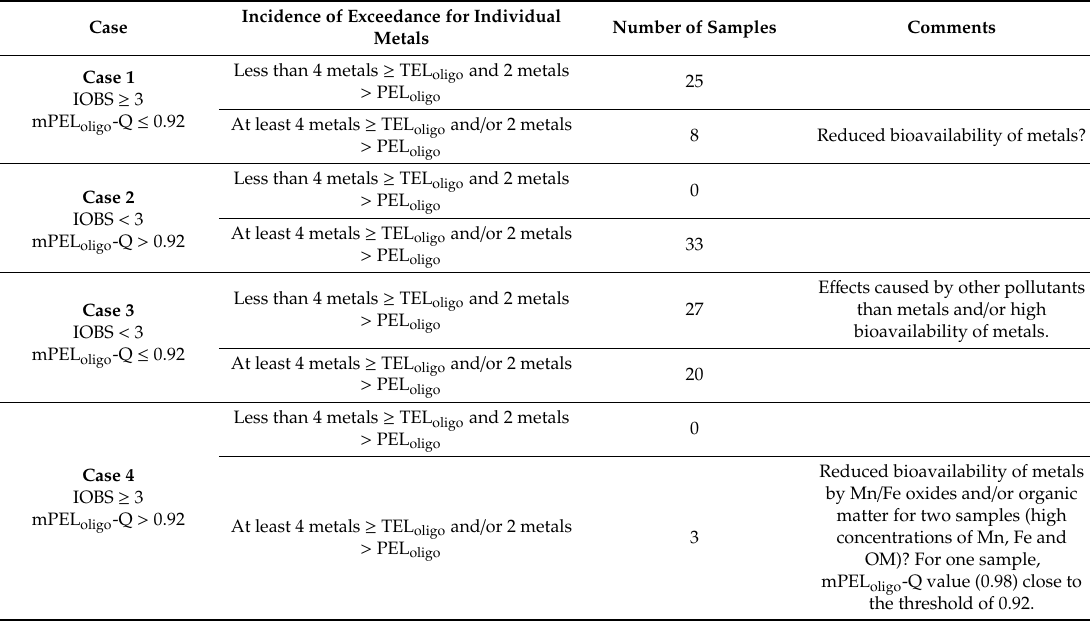
Table 4. Comparison between the Oligochaete index of sediment bioindication (IOBS) values and metal contamination expressed by the mPEL oligo -Q and numbers of metal concentrations exceeding the TEL oligo and PEL oligo